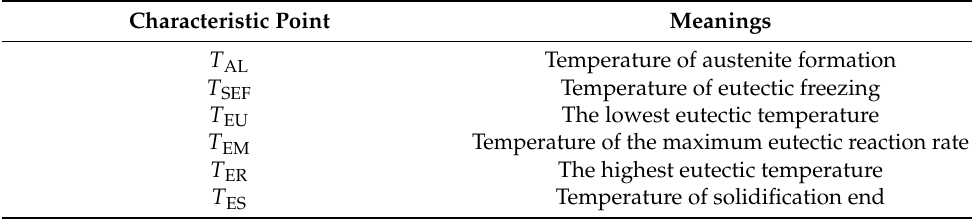
Figure 3. Solidification time of the Ø26 × 55 mm sample with four different neck sizes by simulation: ( a ) No. 1 in Table 3, ( b ) No. 2 in Table 3, ( c ) No. 3 in Table 3, and ( d ) No. 4 in Table 3. Table 3. Meanings of each thermal analysis characteristic point.